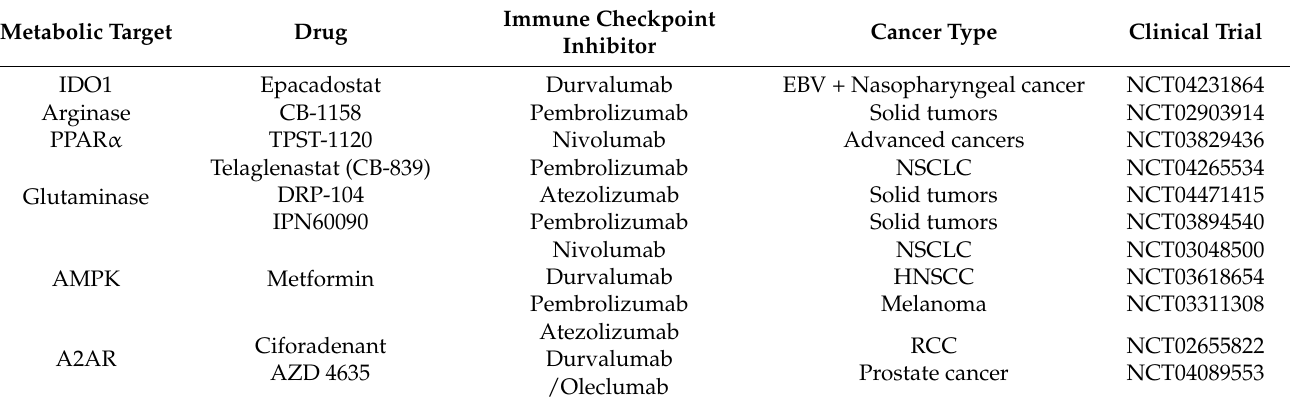
Table 1. Clinical trials combining drugs targeting metabolic reprogramming with immune checkpoint